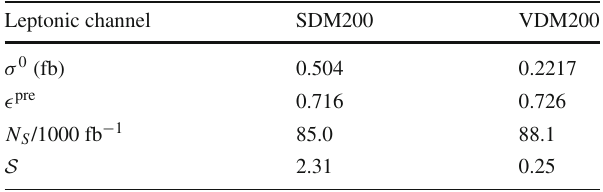
Table 7 The meaning of each row is the same as in Table 4, with the leptonic channel instead Leptonic channel